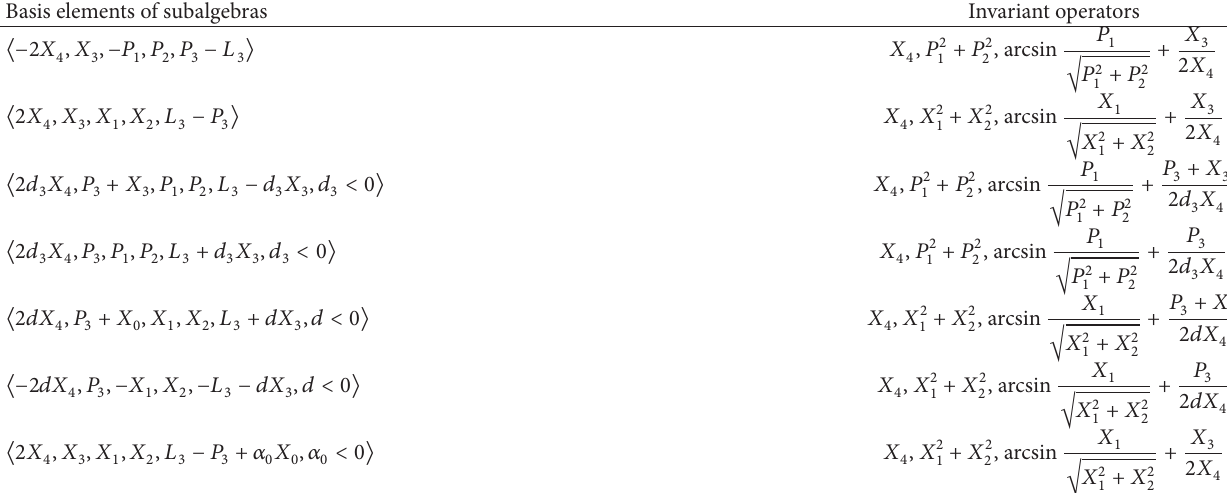
Table 22: Invariant operators of subalgebras of the type 𝐴 𝑝 5,14 (𝑝 = 0)